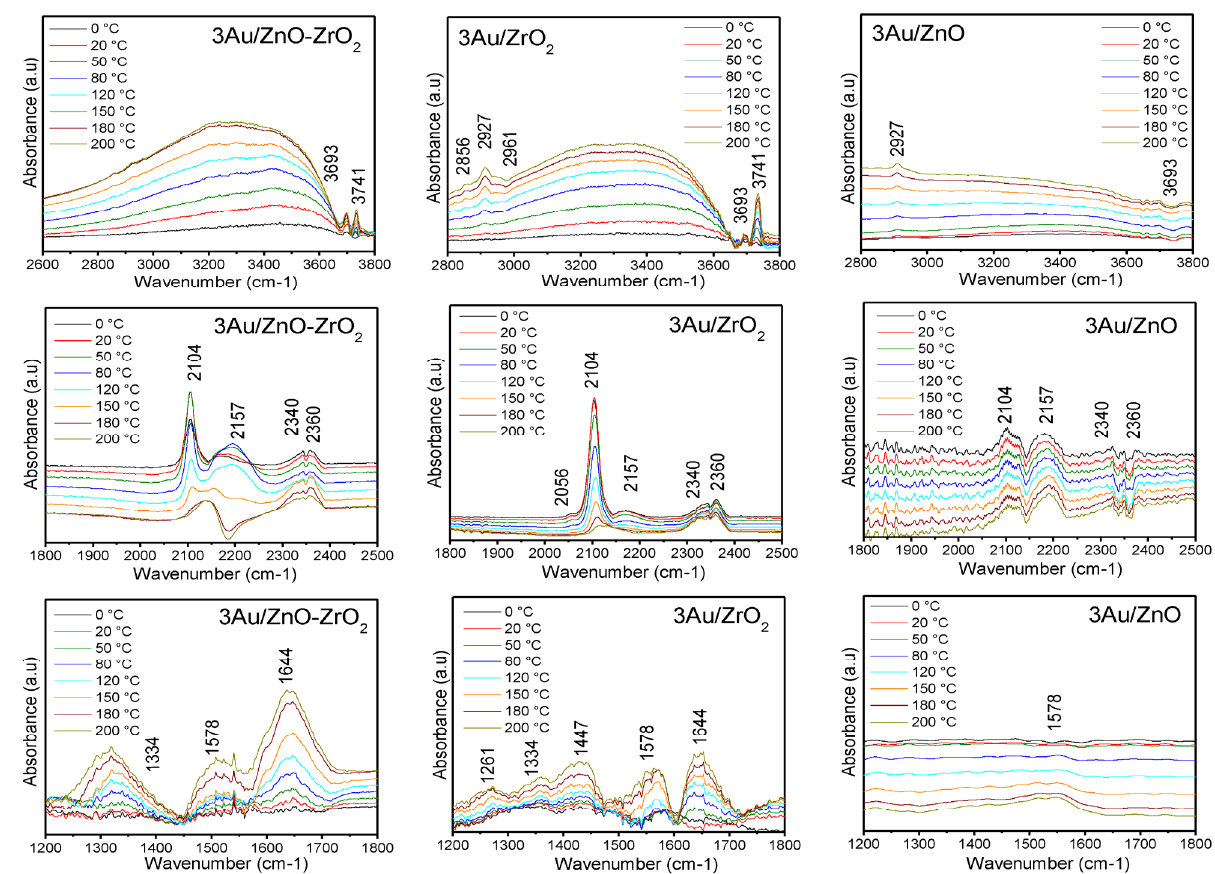
Figure 4. In situ DRIFTS spectra for the 3Au/ZrO 2 , 3Au/ZnO, and 3Au/5ZnO − ZrO 2 catalysts in the CO oxidation from RT to 200 °C at different wavenumber intervals: 3800 − 2200, 3800 − 2800, and 1200 − 1800 cm − 1 .